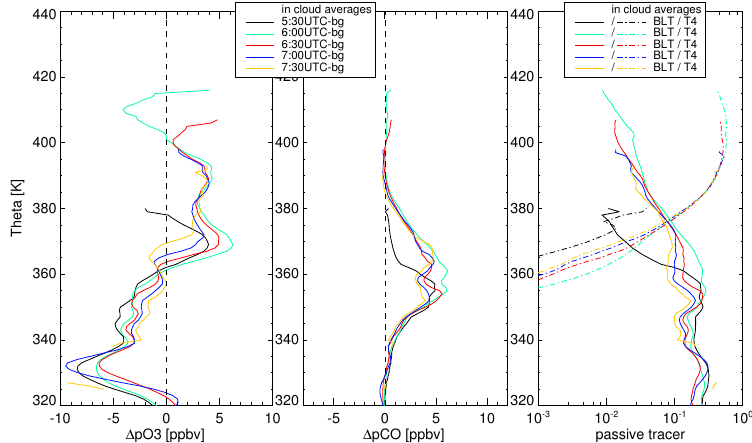
Figure 11. In-cloud average profiles of (cid:49)p O 3 (left), (cid:49)p CO (middle), and BLT and T4 (right).